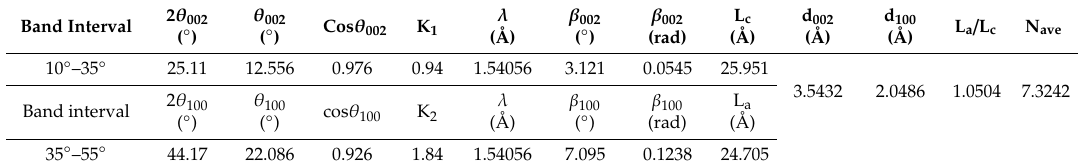
Table 1. Calculation results of structural parameters of the demineralized HNC in ( 002 ) and ( 100 ) bands. Band Interval